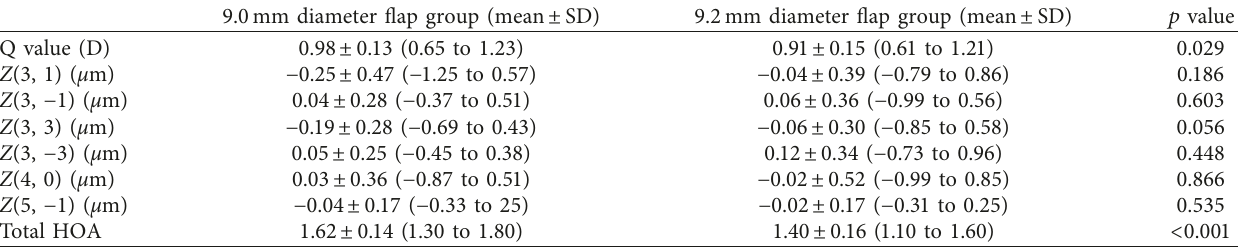
Table 2: The comparison of the postoperative one-year Q value and HOAs of the 9.0 ( n � 34) and 9.2 ( n � 34) mm diameter flap